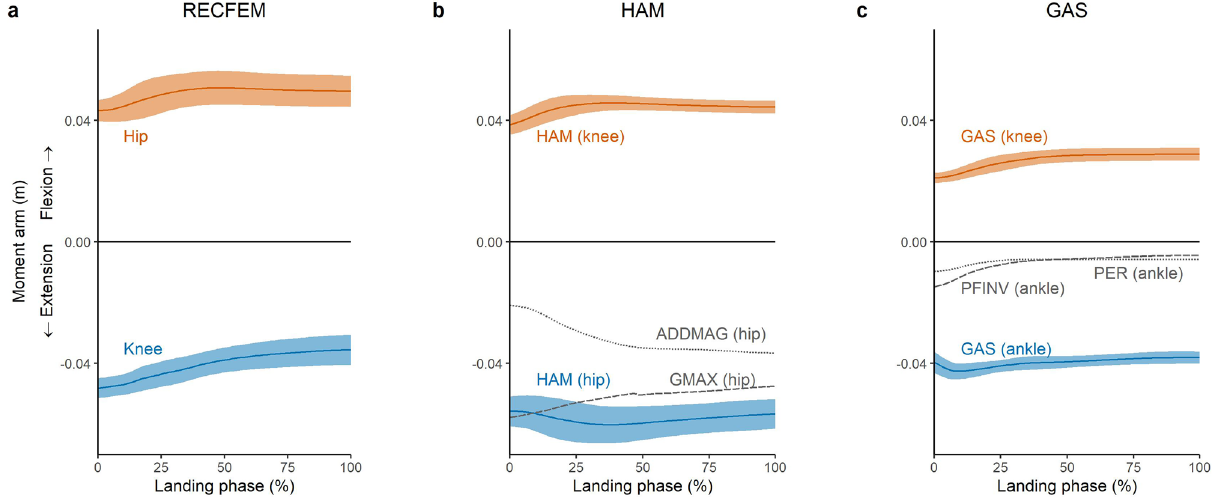
Figure 8. Mean sagittal plane moment arms for biarticular RECFEM (rectus femoris), HAM (hamstrings) and GAS (gastrocnemius) for the landing phase (initial contact to peak knee flexion) of a single-leg drop landing from a 0.31 m height. The blue line and shaded area represent the mean and SD, respectively, of each biarticular muscle’s favourable joint extension moment arm. The orange line and shaded area represent the mean and SD, respectively, of each biarticular muscle’s unfavourable joint flexion moment arm. The grey dotted and dashed lines represent the mean moment arms of other major joint extensors: GMAX, gluteus maximus; ADDMAG, adductor magnus; PFINV, plantar flexor invertors (average of tibialis posterior, flexor hallucis and digitorum longus). The VASTI (vastus lateralis, medialis and intermedius) and soleus moment arms were not visualised due to common attachments with the RECFEM and GAS,